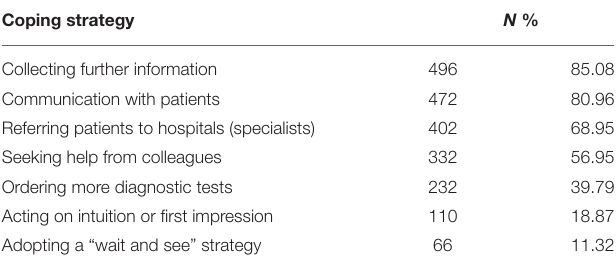
( Figure 1 ). About 60% of the participants ( n = 345) fell into the LCA group of high openness and collaborativeness ( Figure 2 ). Those facility, and attended antibiotic training were more likely to be classified with high openness and collaborativeness ( p < 0.05, Supplementary Table S2 ). The split of participants according to their summed DUQ scores, whether 50/50 or 40/60, generated a result of 83% agreement with the LCA classification ( p < 0.001 in Kappa